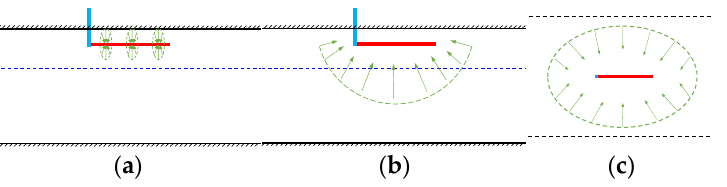
Figure 4. Typical flow patterns of horizontal wells in bottom water reservoir with finite water bodies. ( a ) Early vertical radial flow stage; ( b ) hemispherical flow stage; ( c ) late system pseudo radial flow stage.